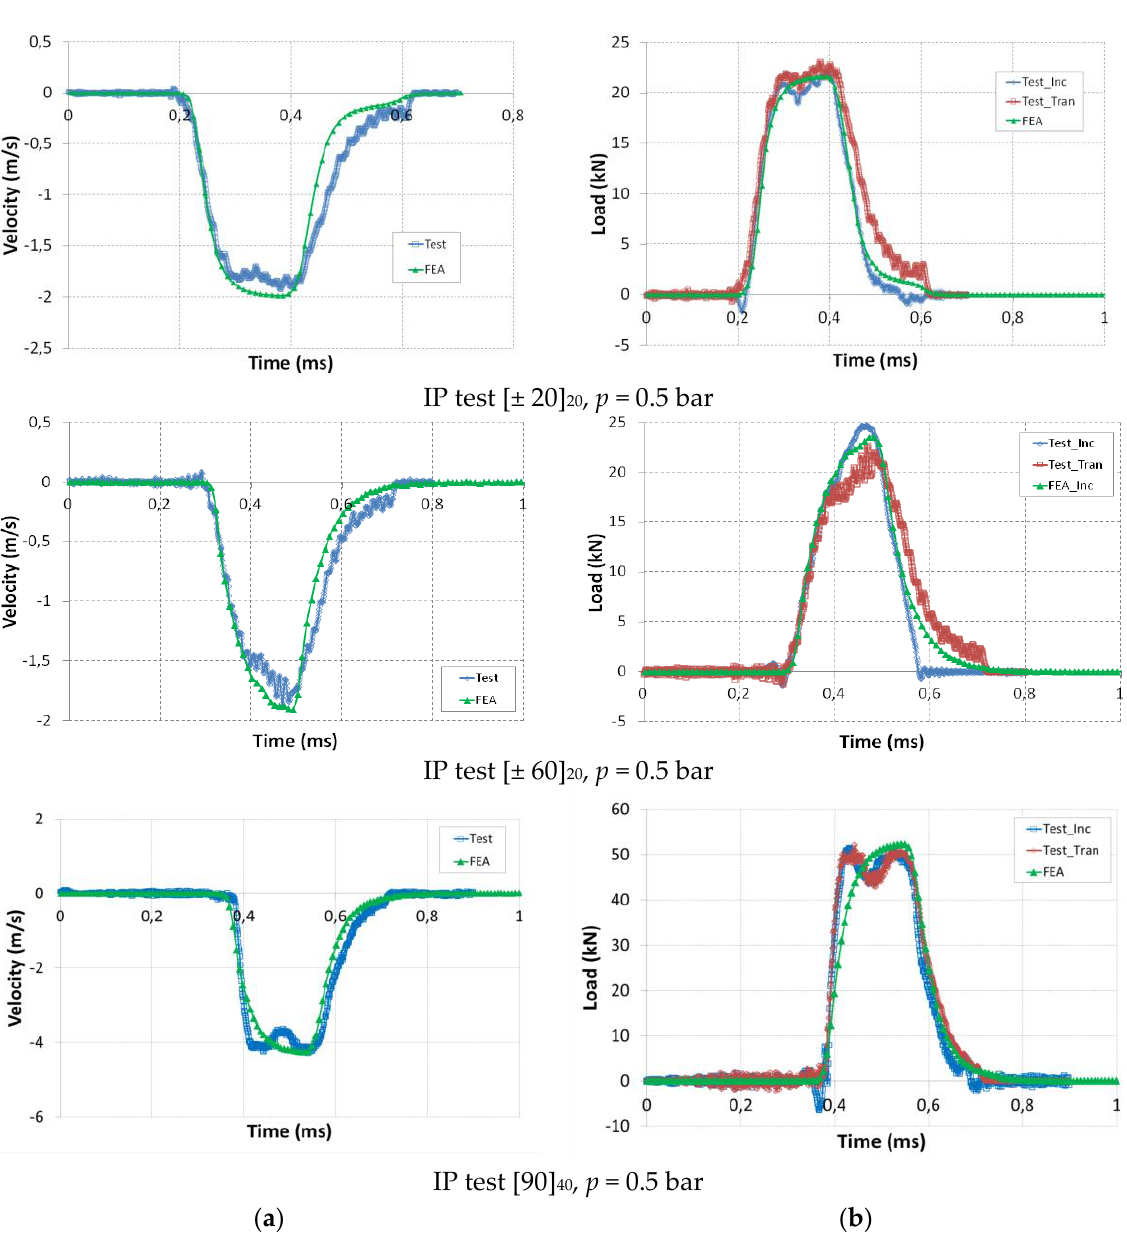
Figure 5. Correlation of experimental/numerical results. ( a ) Transmitted velocity. ( b ) Incident and transmitted